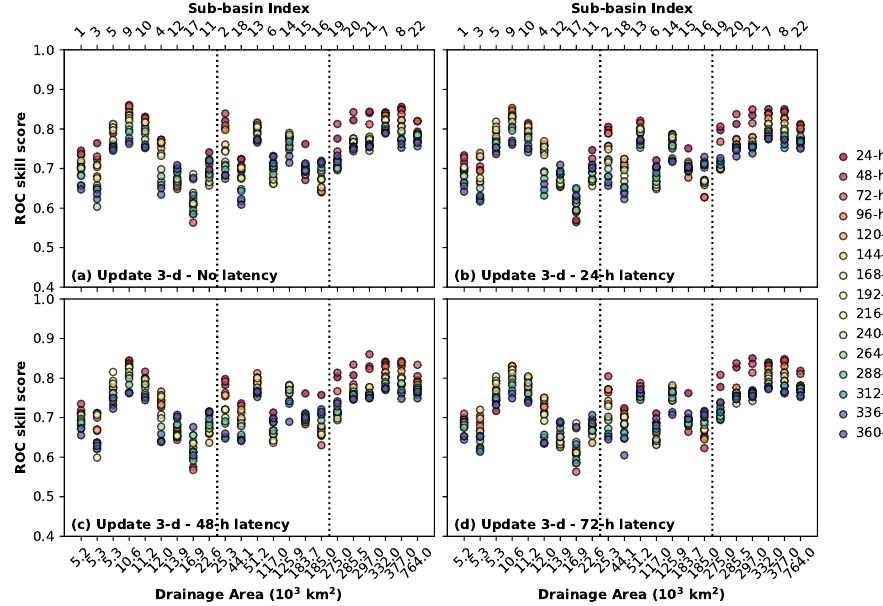
Figure 6. ROC skill score for 22 sub-basins of the Tocantins-Araguaia Basin for 15 lead times as a function of drainage area for streamflow with a probability level of 0.9. MHD-INPE update every 3 d and ( a ) no latency, ( b ) 24 h latency, ( c ) 48 h latency, and ( d ) 72 h latency to the ECMWF ensemble. The vertical dotted lines divide the drainage area into small, medium, and large